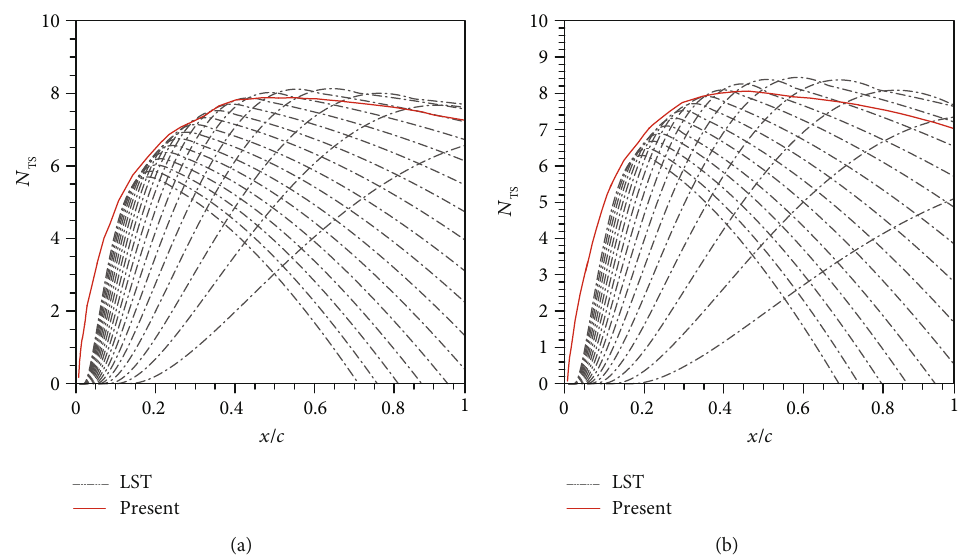
Figure 13: The predicted N factor on the (a) upper surface and (b) lower surface with angle of attack of 2 ° TS